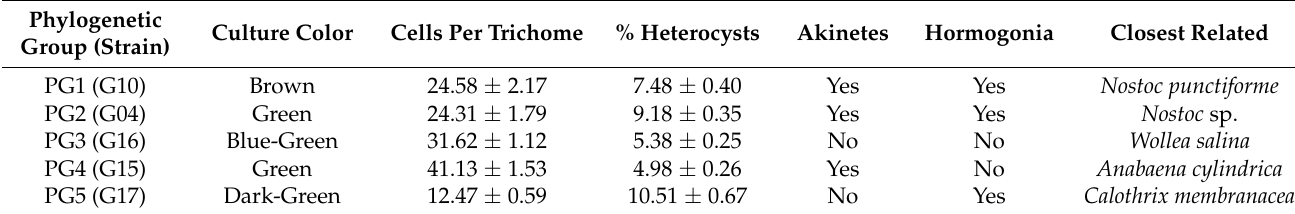
Figure 4. Morphological illustrations of 5 strains used in this work. ( A ) Strain G10 from PG1, ( B ) strain G04 from PG2, ( C ) strain G16 from PG3, ( D ) strain G15 from PG4, and ( E ) strain G17 from PG5. H: Heterocysts; A: Akinetes; and Horm: Hormogonia. Table 1. Morphological characters of 5 cyanobacterial strains used in this